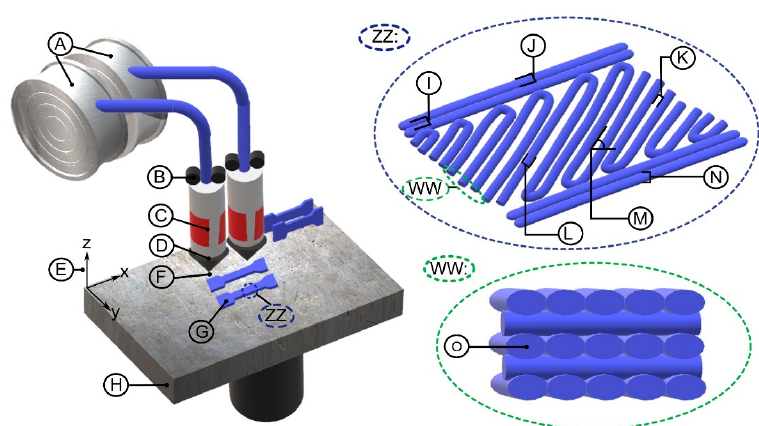
Figure 1. FDM (fused deposition modeling) technology principal components are represented by A material and support canisters, B rollers, C heating resistor, D nozzle, E build direction ( z -axis), F nozzle tip, G component, and H building bed; FDM build parameters (ZZ zoom) are represented by I number of contours, J contour width, K air gap, L filament width, M angle of deposition, and N layer thickness; and filament’s characteristic (WW zoom of the deposited filaments) is represented by O ellipsoid shape of filament.